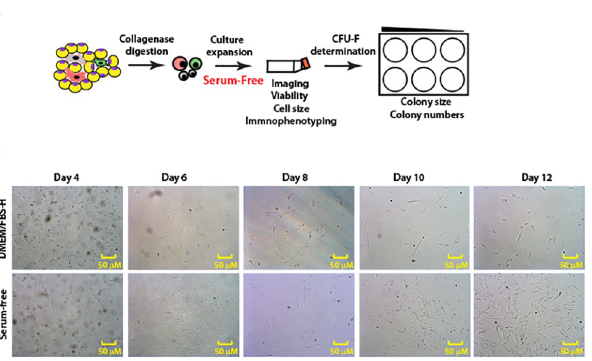
Fig 7. Serum-free medium containing bFGF and PDGF facilitates isolation and expansion of canine Ad-MSCs. A . Schematic to evaluate serum-free medium containing bFGF and PDGF for direct derivation and expansion of canine Ad-MSCs. Freshly isolated canine Ad-MSCs from 3 additional donors (donors 4–6) were placed directly into serum- free medium containing bFGF and PDGF. Canine Ad-MSCs were also placed into DMEM/FBS-H to compare the growth characteristics of canine Ad-MSCs in both culture media. B . Photomicrographs of canine Ad-MSCs from donor 4 imaged at indicated days of culturing.